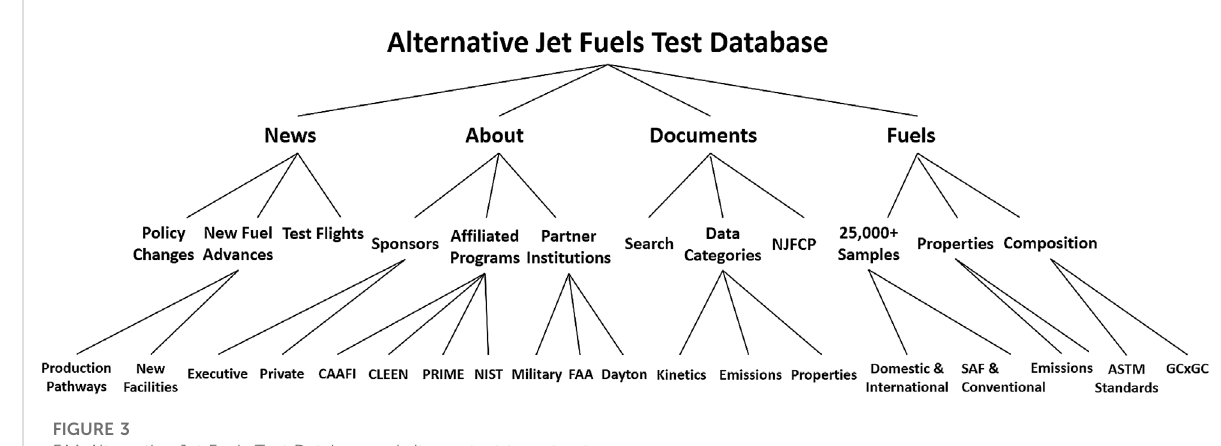
FIGURE 3 FAA Alternative Jet Fuels Test Database website content tree